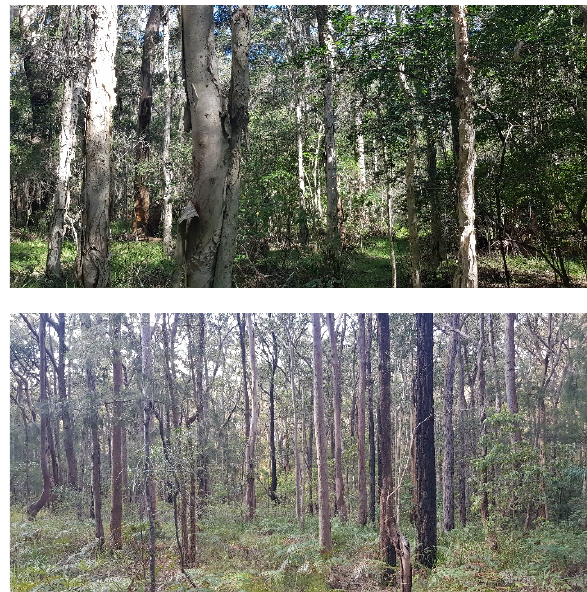
Figure 20: Images from the test site for elevation fuel: more than 30% coverage (above) and less than 20% coverage